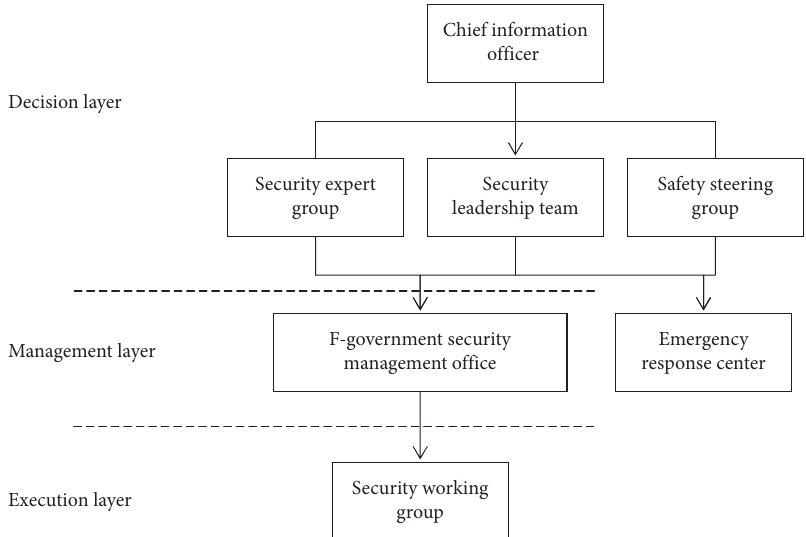
Figure 8: Hierarchical information security